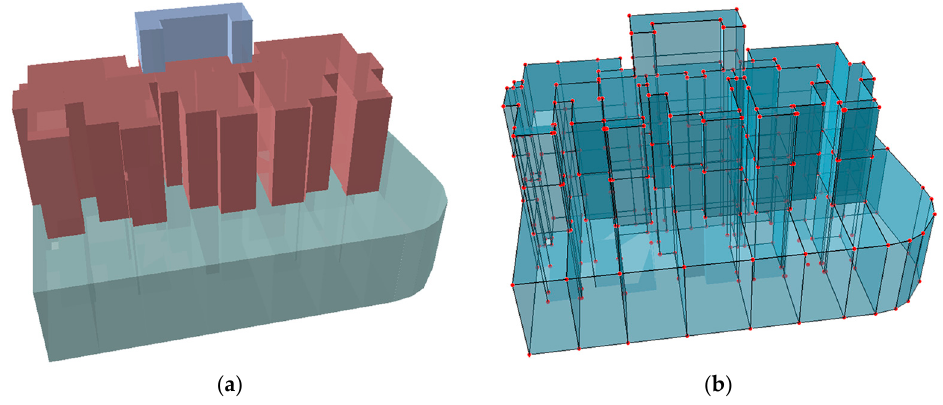
Figure 20. 3D geometric model ( a ) and topological features ( b ) of the property units of the building complex.